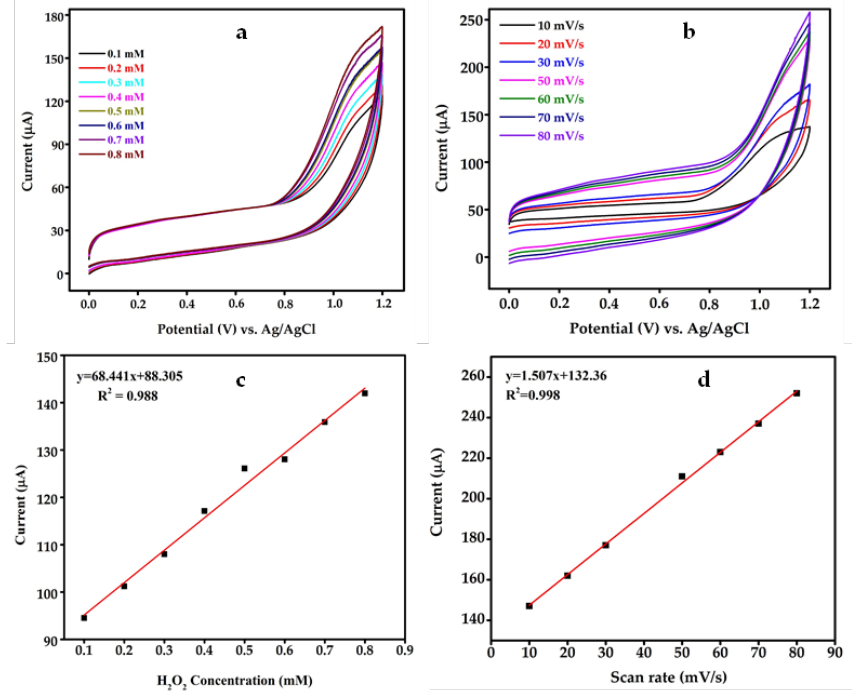
Figure 5. ( a ) Cyclic voltammograms curve of SnO 2 QDs/GO/PPy ternary composite modified GCE measured in 0.1 M PBS (pH 7.4) containing different concentrations of H 2 O 2 ; ( b ) CV curve of SGP2 modified GCE at different scan rates; ( c ) the plot of peak current vs. concentration of H 2 O 2 ( d ) the plot of peak current vs. scan rates.